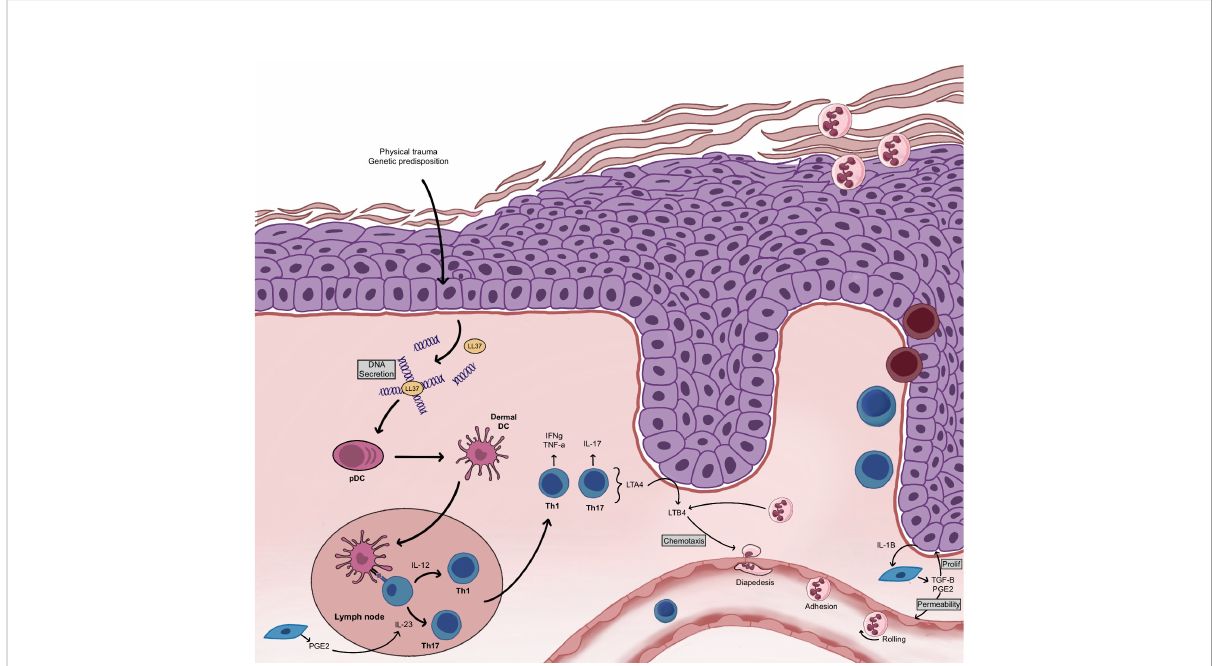
FIGURE 5 Establishment of the psoriatic plaque. Following a physical trauma or triggered by genetic predispositions, keratinocytes secrete their own DNA. The pDC become activated and stimulate the dermal DC. Dermal DC present their antigen to T cells, which induces T cell recruitment, CD4+ T cell polarization toward a Th1 and Th17 phenotype and CD8+ T cell migration to the epidermis. Keratinocytes enter into hyperproliferation. Neutrophils are recruited and migrate to the stratum corneum. LTB4 contributes to neutrophil chemotaxis while PGE 2 contributes to keratinocyte